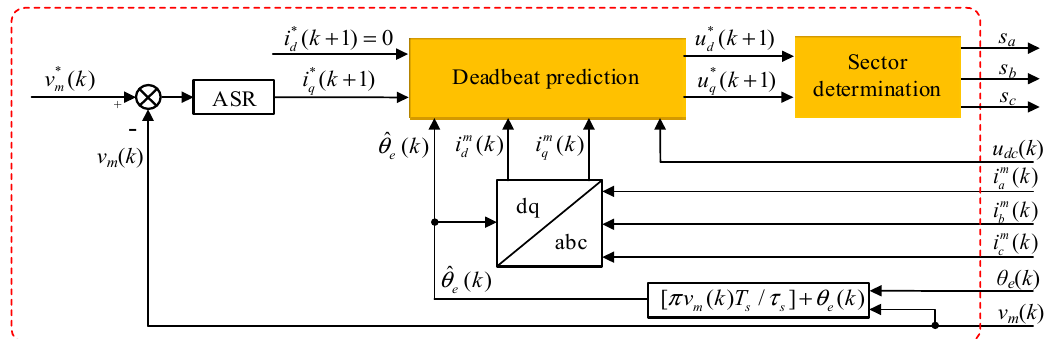
Figure 4. MPCC-II for the PPMLM traction system.